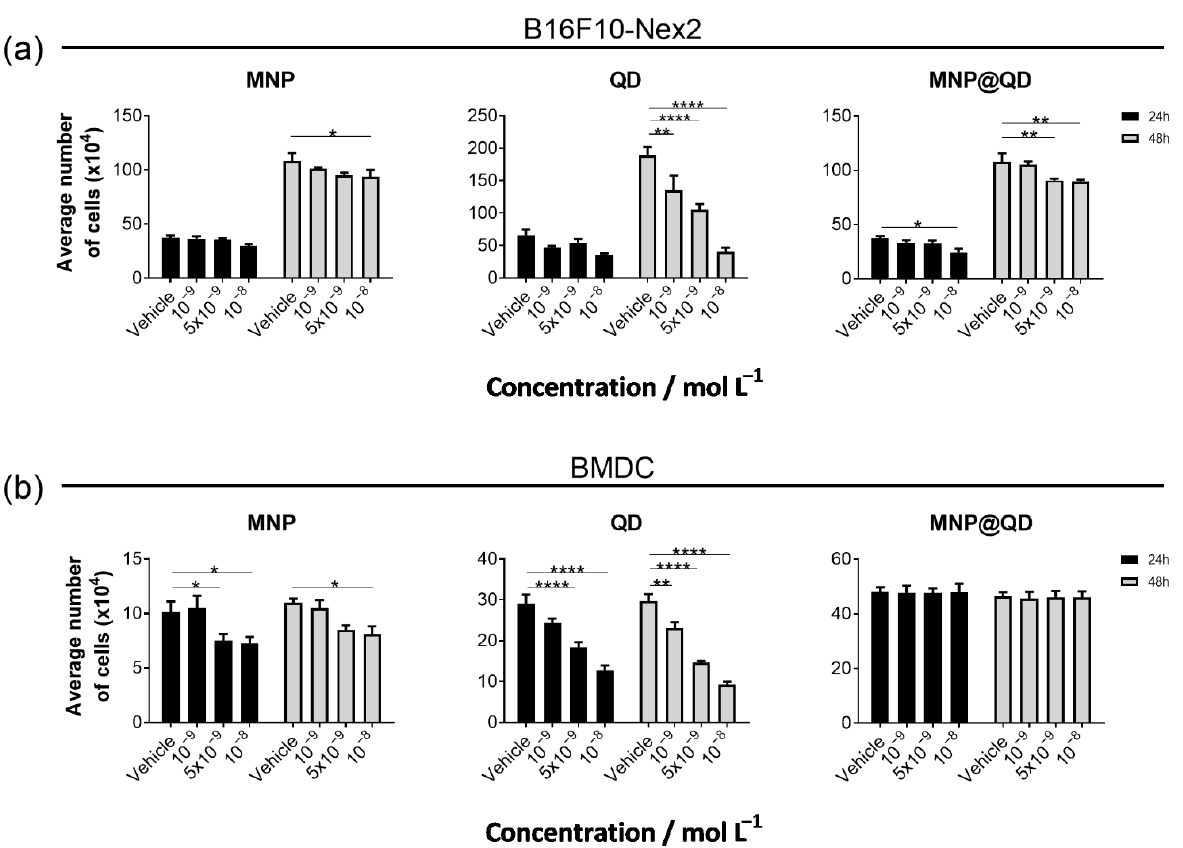
Figure 3. Toxicity evaluation of MNP, QD, and MNP@QD in melanoma cells ( a ) and BMDCs ( b ) after 24 h and 48 h with each nanoparticle. Cell viability was assessed with the Trypan Blue method. Each bar represents the average of five replicates. Error bars represent the standard error of the mean (SEM). Graphs are representative of three independent experiments. * p < 0.05; ** p < 0.01; **** p < 0.0001. Statistical significance was obtained with 2way ANOVA with Dunnet’s multiple comparisons test.